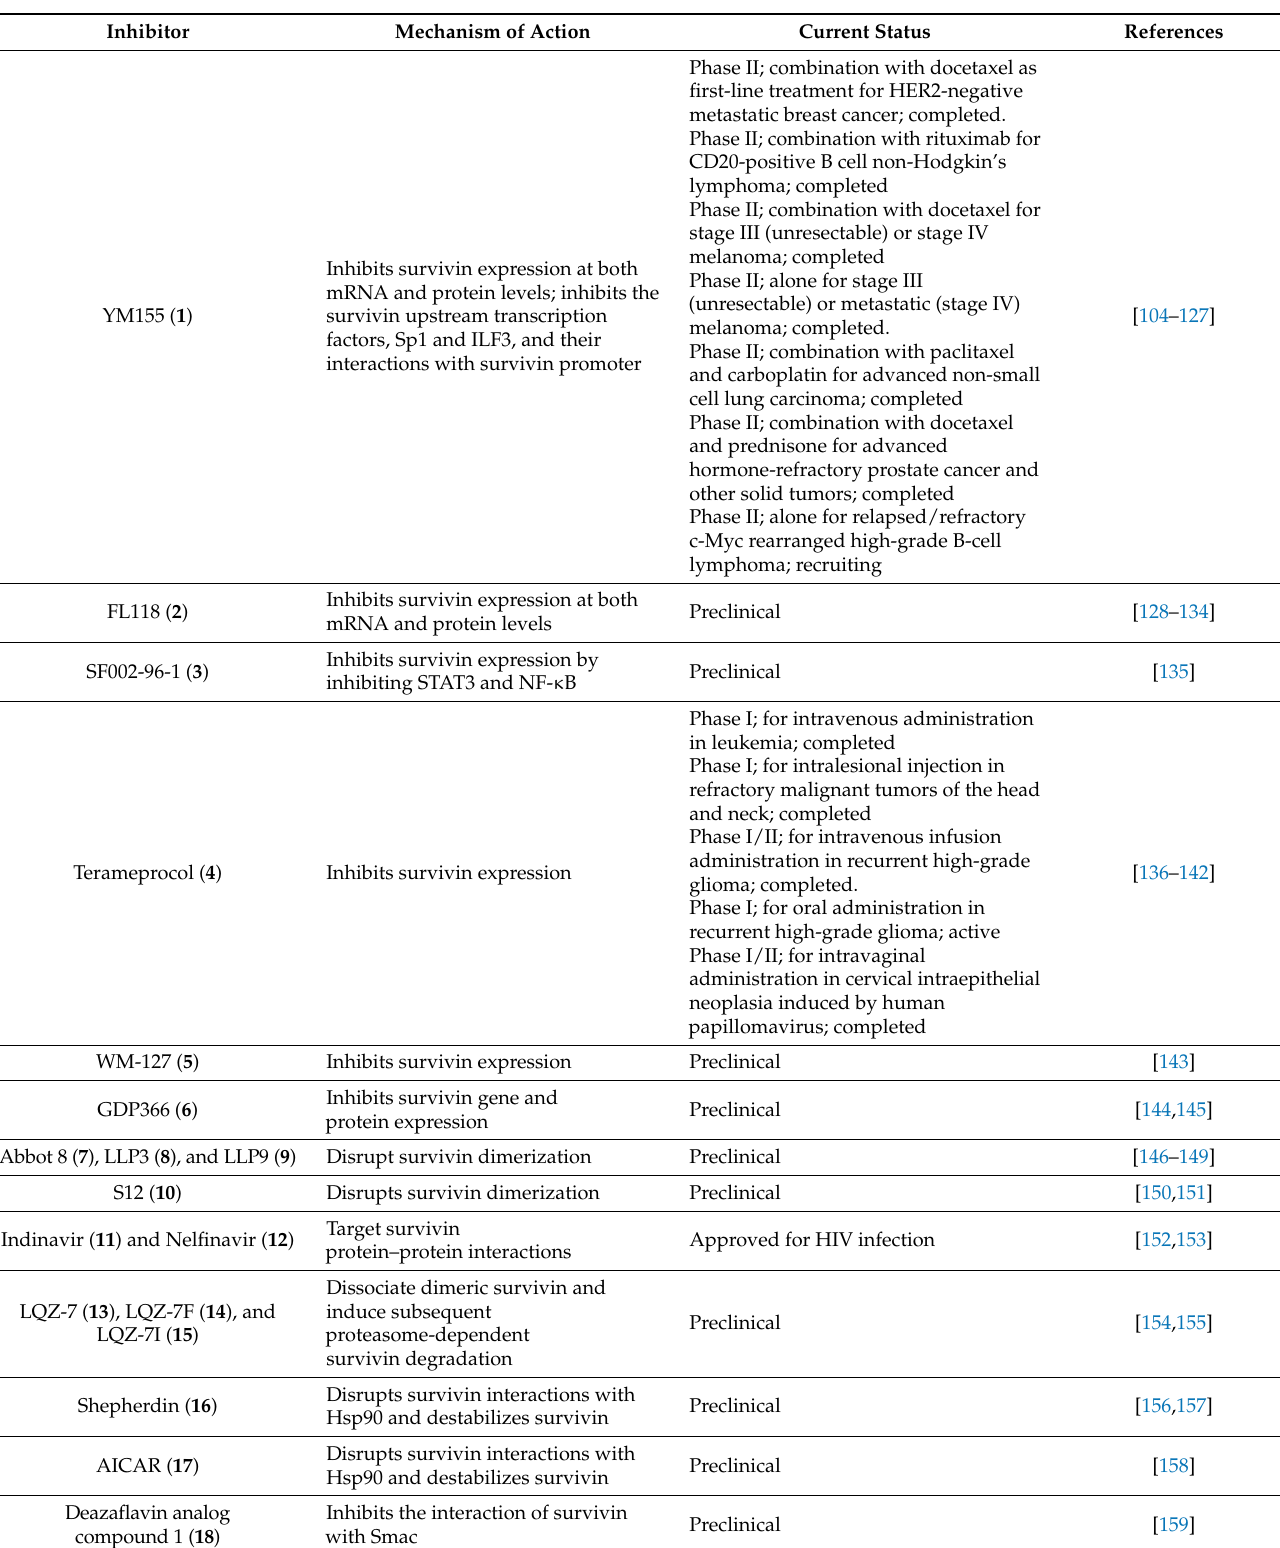
Table 1. Small-molecule survivin inhibitors reviewed in this